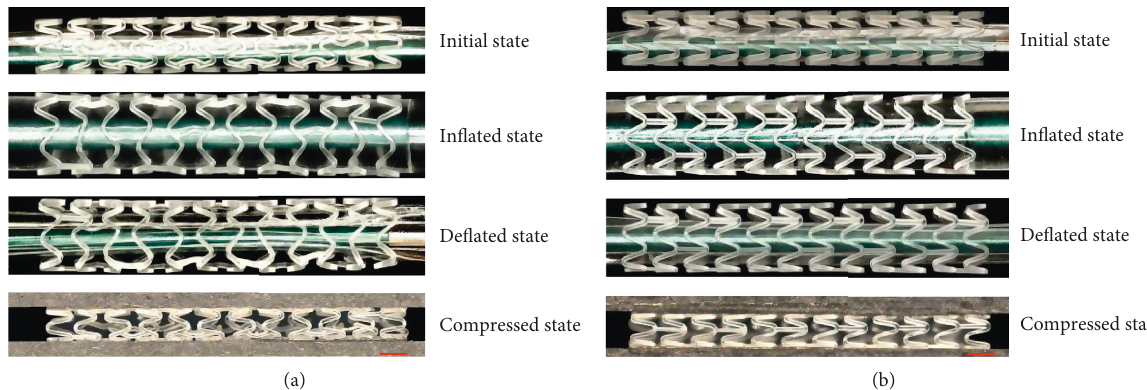
Figure 18: Deformations of the (a) OCS and (b) BVS at different states during in vitro expansion test and planar compression test. Scale bars: 1.0mm. Table 3: Outer diameters and lengths of OCS and BVS at different states during in vitro experiments. Stent type